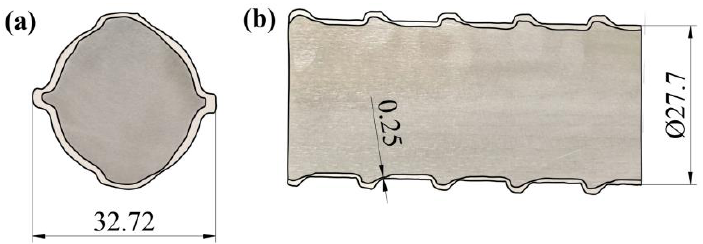
Figure 3. Cross-section images of the 55#/316L rebar (wt. mm): ( a ) end surface and ( b ) axial